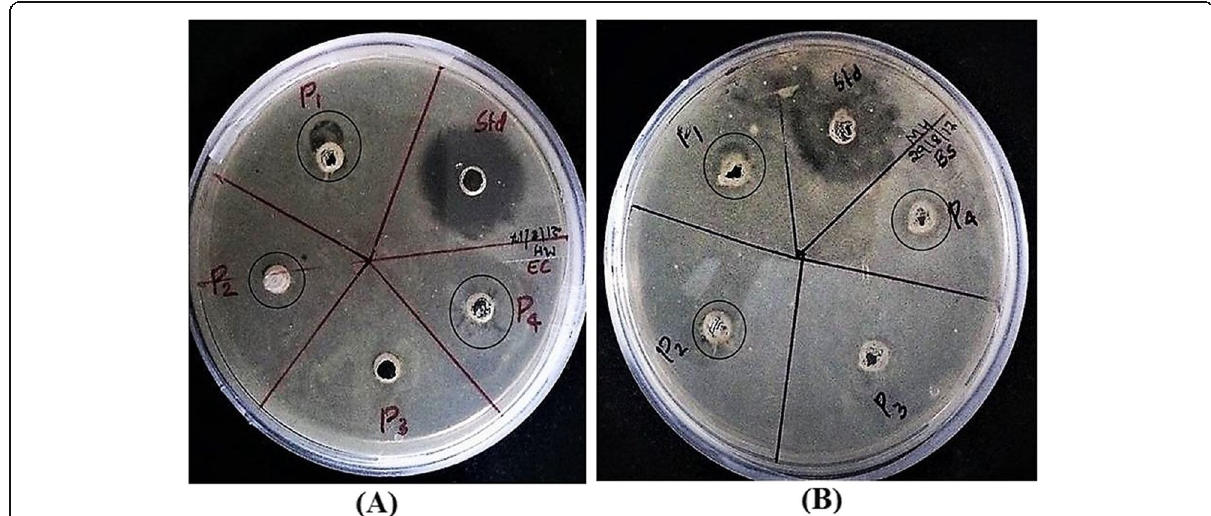
Fig. 3 Antibacterial activity of methanol (P1), chloroform (P2), n -hexane (P3), and aqueous (P4) extracts of fresh papaya flowers using well diffusion assay. a Activity against Escherichia coli (Gram-negative). b Activity against Bacillus subtilis